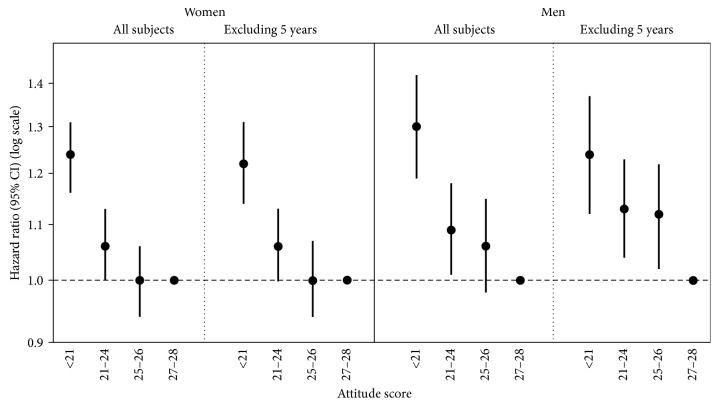
Attitude score and hazard ratios of death: the Leisure World Cohort Study, 1981–2016. Note: data shown are from analyses of total attitude score as quartile categories excluding persons with missing items. HRs and 95% confidence intervals derived from Cox regression analysis model 2, which adjusts for age (as the time scale), smoking, body mass index, exercise, alcohol intake, caffeine consumption, and histories of hypertension, angina, heart attack, stroke, diabetes, rheumatoid arthritis, and cancer.